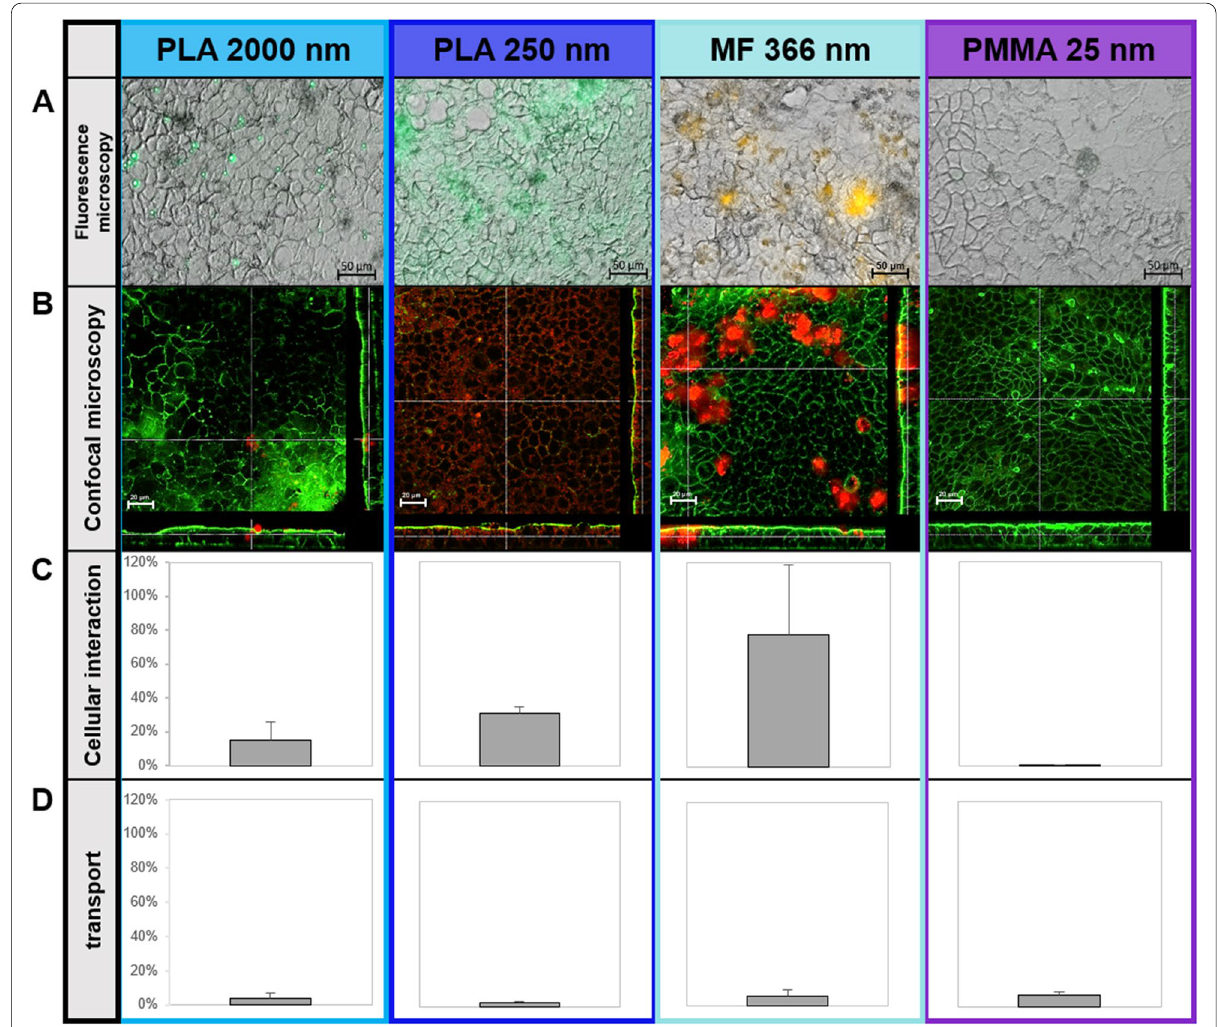
Fig. 3 Analysis of uptake and transport of particles through the intestinal epithelial Caco-2 cell monolayer after 24 h incubation in a Transwell ® system. A Representative fluorescence microscopic images. Gray spots indicate the Caco-2 cells and colored spots indicate particles. B Representative confocal microscopic images. Green spots indicated the Caco-2 Monolayer and red spots the particles. C Fraction of particles interacting with the Caco-2 cell monolayer (uptake or laying on top of the cells) determined with a plate reader. D Percentage of particles transported through the Caco-2 cell monolayer determined with a plate reader. Data are shown as mean